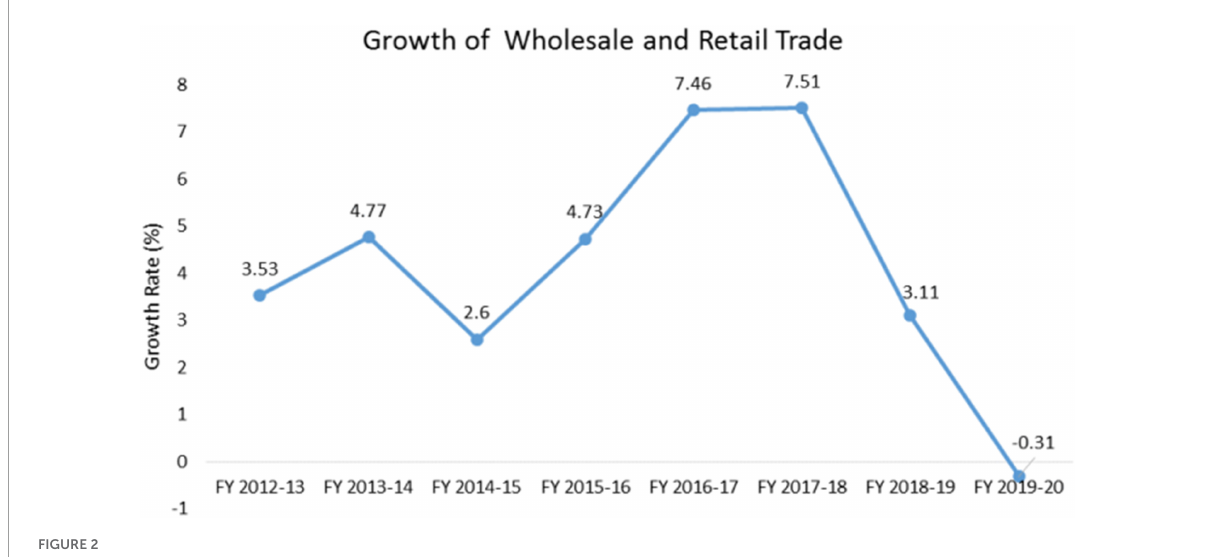
FIGURE2 Covid19 and Innovation in Retail- Pakistan’s Growth Industry, 2020. Estimated model after